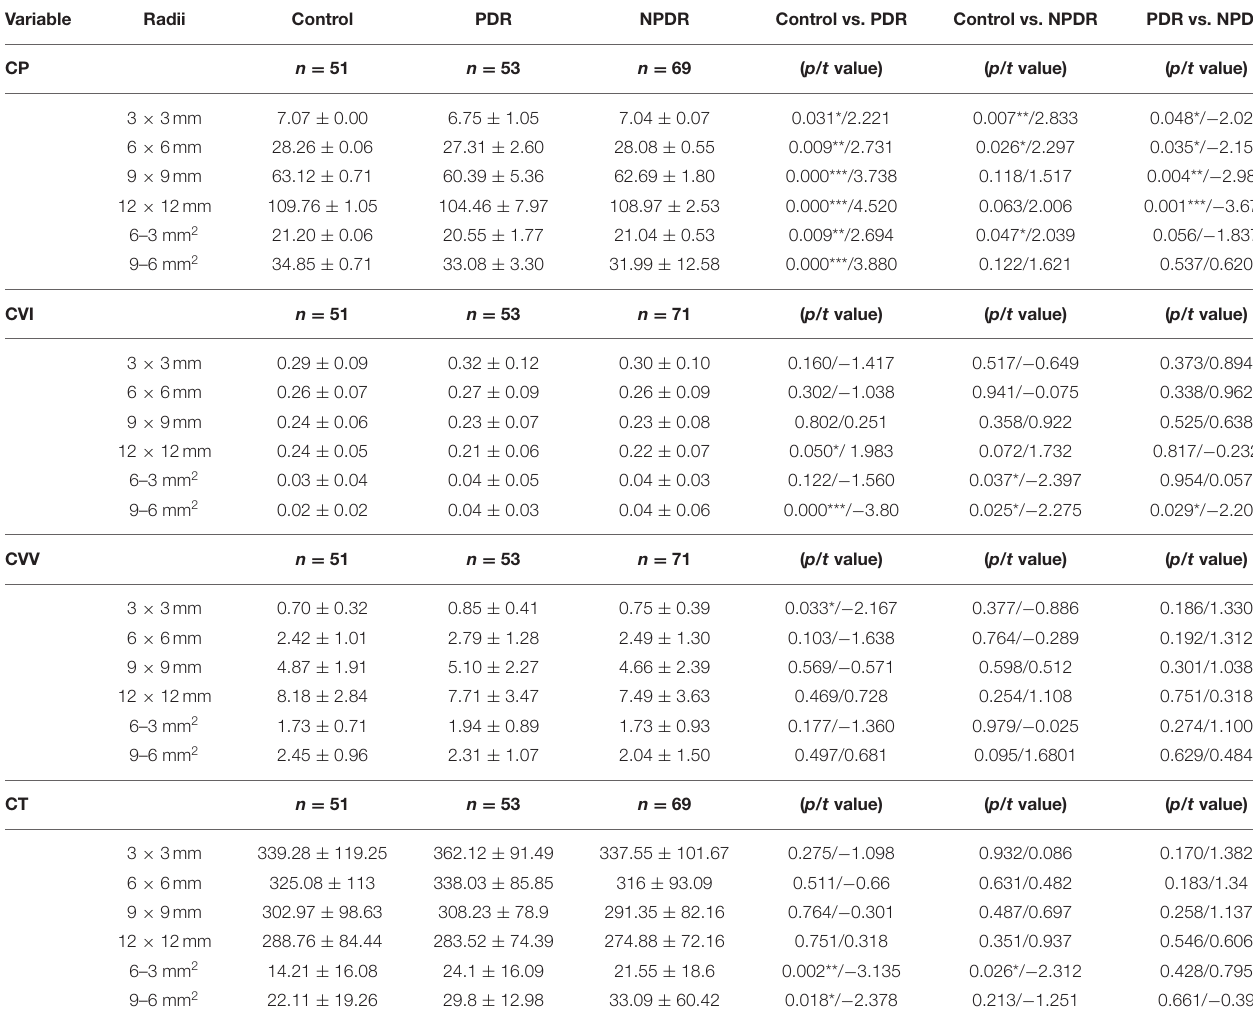
TABLE 3 | SS-OCTA evaluated the choroidal indices with different radii centered on the macular fovea in control eyes, PDR eyes, NPDR eyes (mean ± SD, p -value). Variable Radii Control PDR NPDR Control vs. PDR Control vs.